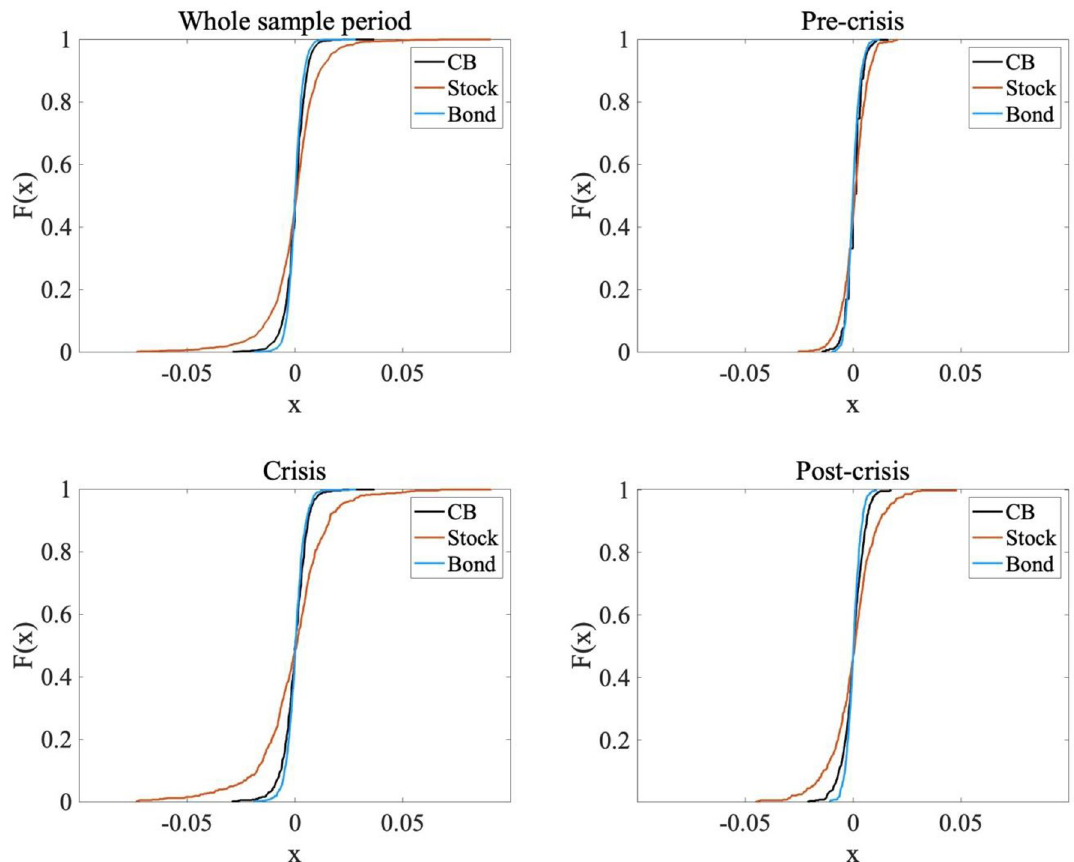
Fig 1. Cumulative density function of the return of CB, stock, and bond in four subsample periods: Whole sample, pre-crisis, crisis, and post-crisis periods.